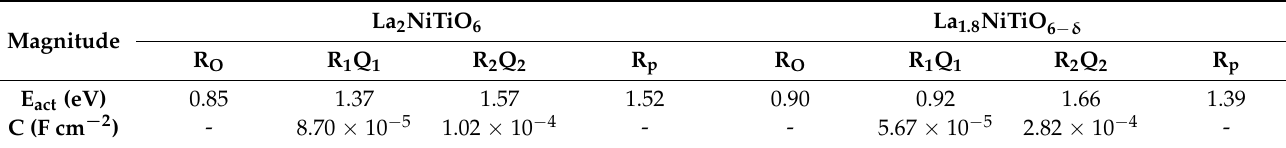
Table 1. Impedance data of La 2 − x NiTiO 6 − δ (x = 0 and 0.2) in the 1173 to 923 K temperature range.